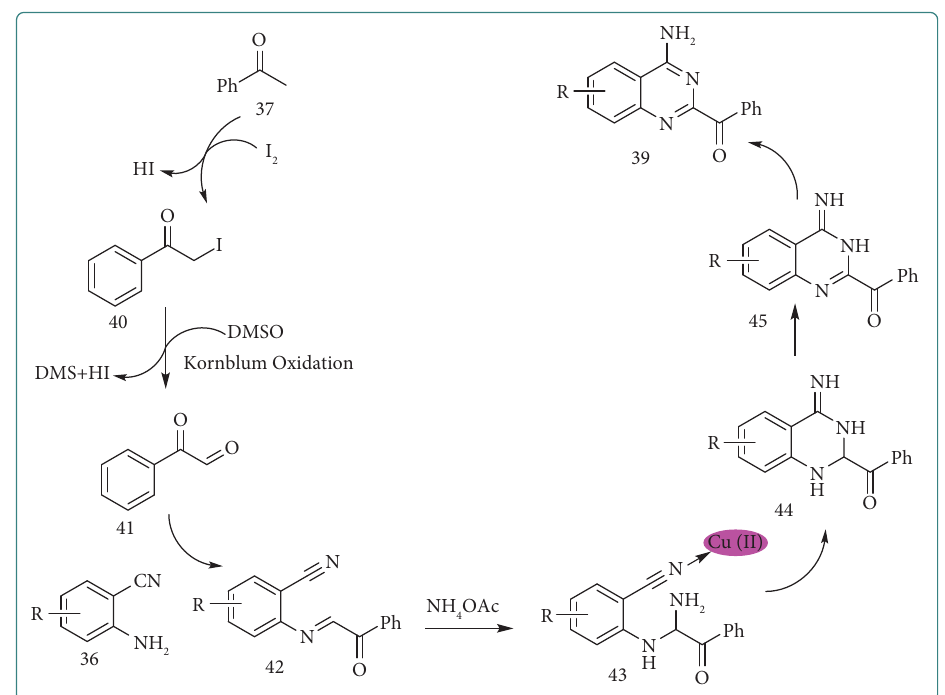
Figure 7: Te possible mechanism for the synthesis of 2-acyl-4-aminoquinazolines in the presence of I